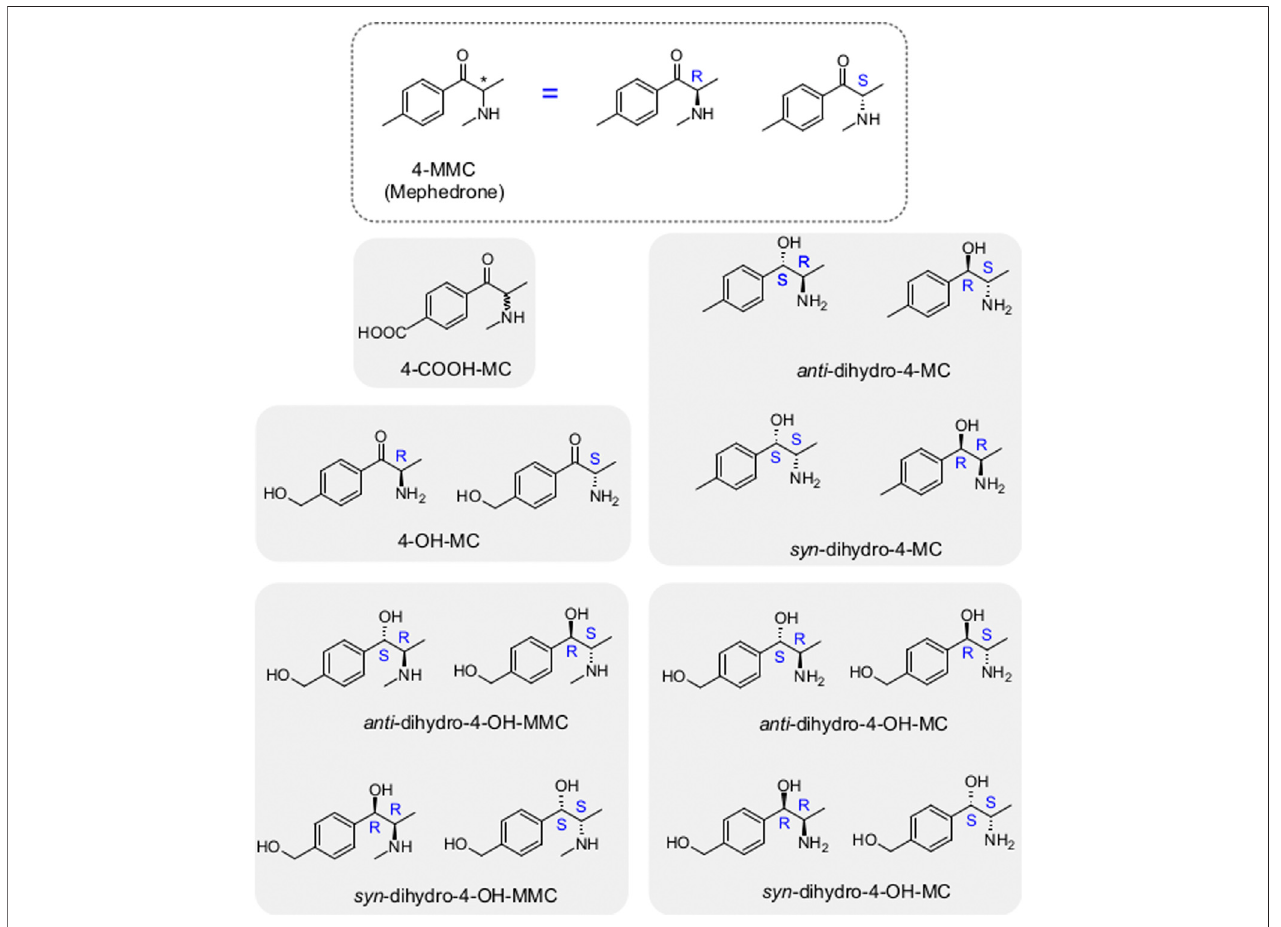
FIGURE 1 | Mephedrone metabolites analyzed in the current study. On top is highlighted mephedrone structure with its stereocenter (asterisk) which leads to the twoenantiomers(R-andS-mephedrone).Themetabolitesanalyzedinthecurrentstudyarehighlightedbythegreyrectanglesinthebackgroundwiththeenantiomersof the same metabolite being grouped within the same rectangle. Note that in the case of the 4-COOH-MC only the racemate was tested.